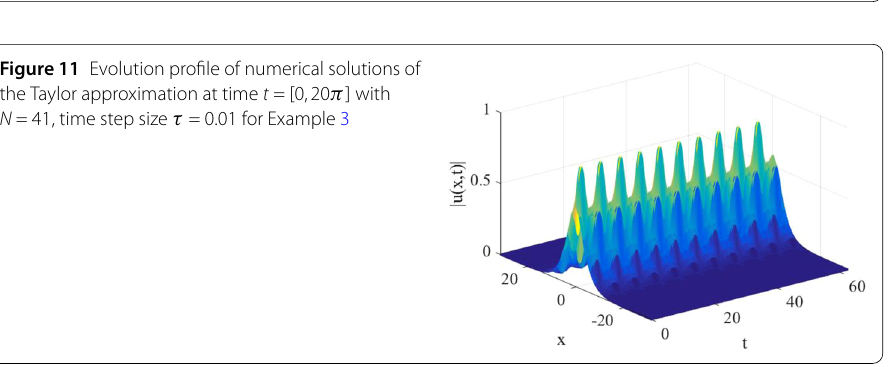
Figure 10 The exact solutions and numerical solutions (on left-hand side figure) and the errors between Taylor approximation and exact solutions (on right-hand side figure) with N = 21 and time step size τ = 0.01 at t = 20 π for Example 3